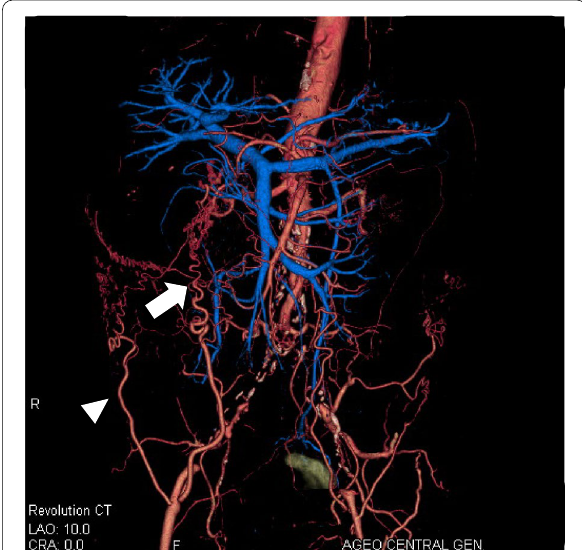
Fig. 3 The abdominal aorta was occluded from below the renal artery bifurcation to around the common iliac artery bifurcation. Blood flow to the lower limbs was supplied through the inferior epigastric arteries and deep circumflex iliac artery (white arrow)